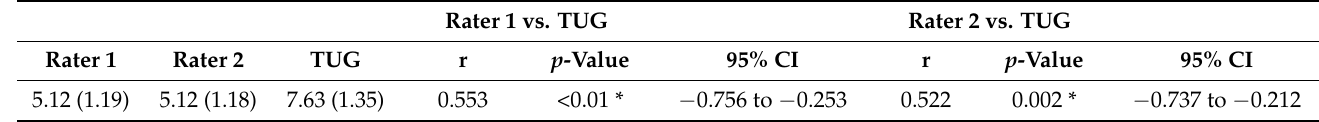
Table 3. Validity of the